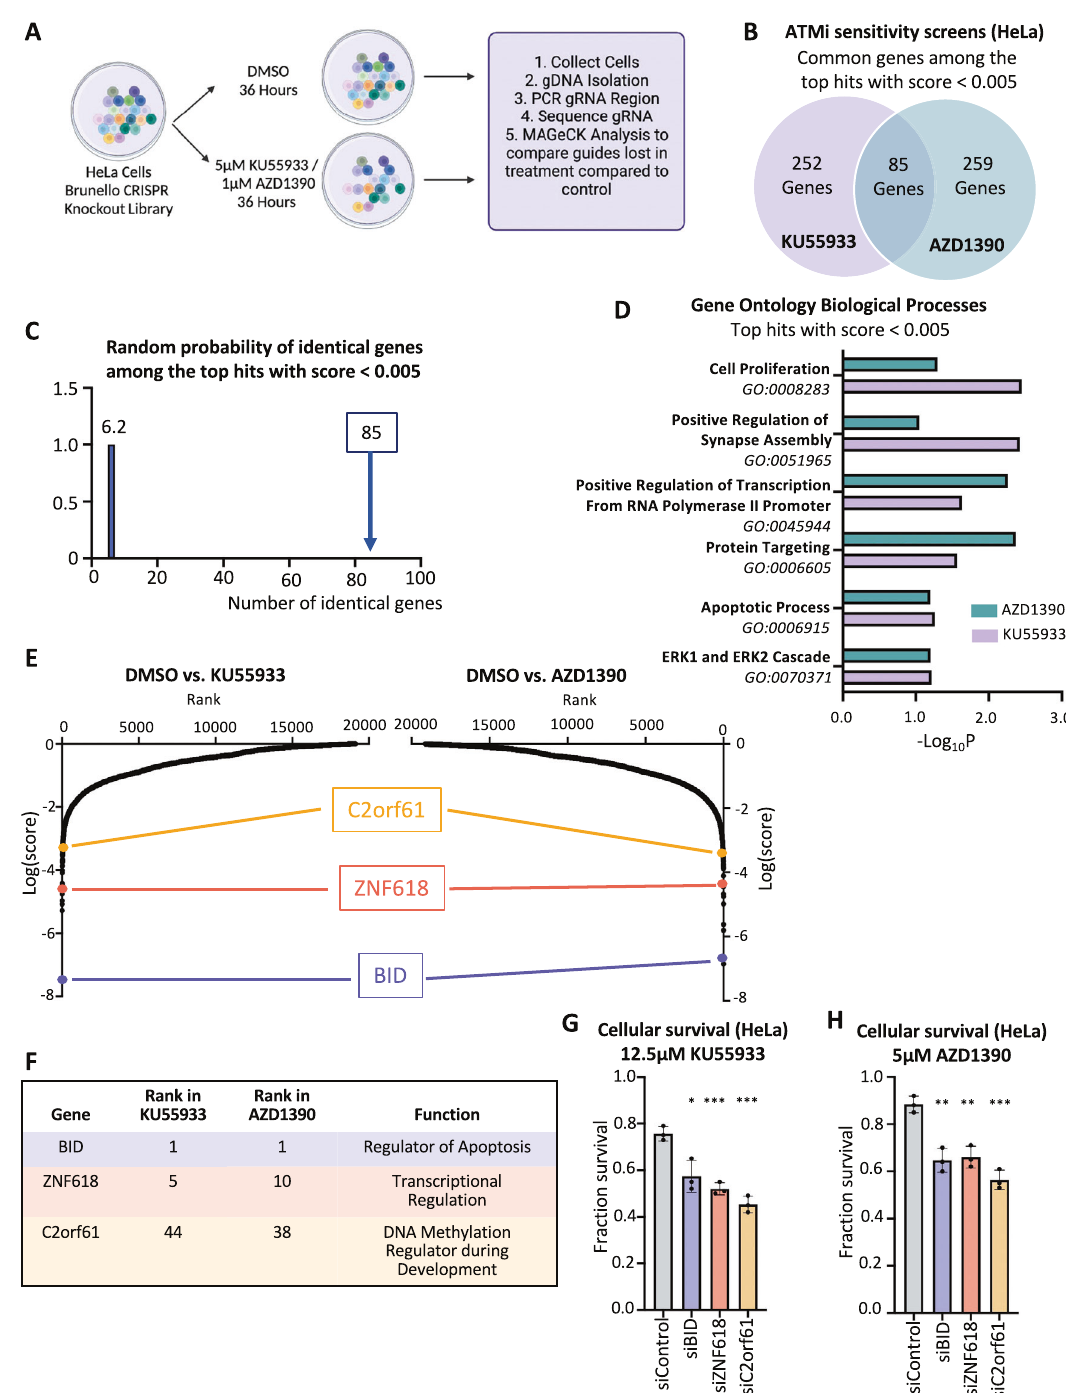
Fig. 5 Genome-wide CRISPR knockout screens identify common genes which regulate the cellular sensitivity to multiple ATM inhibitors. A Overview of the CRISPR knockout screens to identify genes that regulate the sensitivity to the ATM inhibitors KU5933 and AZD1390 in HeLa cells. B Diagram showing the overlap of identical genes within the top hits from both ATMi screens with MAGeCK score < 0.005. C The number of common genes within the top hits with MAGeCK score < 0.005 (namely 85) is much higher than the random probability of identical hits, which is 6.2. D Biological pathways that were signi fi cantly enriched within the top hits with MAGeCK score < 0.005 from both ATMi screens using Gene Ontology Biological Processes (GO_BP) analysis. E Scatterplots showing the results of the ATMi sensitivity CRISPR knockout screens in HeLa cells. Each gene targeted by the library was ranked according to the MAGeCK score. Three top hits common between the two ATMi screens, chosen for subsequent validation, are indicated. F Table showing the ranks in each of the screens, and the biological functions of the three top common hits chosen for subsequent validation. G , H Cellular survival assays showing that knockdown of BID, ZNF618, or C12orf61 in HeLa cells results in sensitivity to the ATM inhibitors KU5933 ( G ) and AZD1390 ( H ). The average of three experiments is shown. Error bars represent standard deviations, and asterisks indicate statistical signi fi cance ( t -test, two-tailed, unpaired). Western blots con fi rming the knockdown are shown in Supplementary Fig. S4A, B.